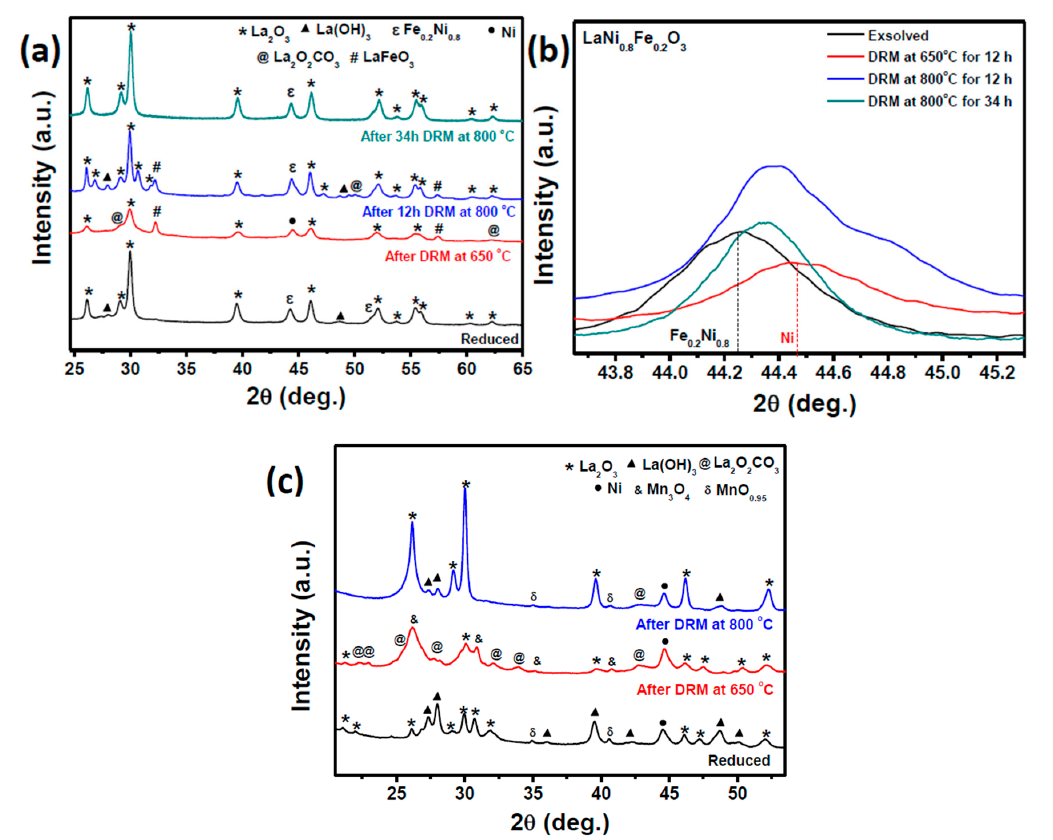
Figure 5. XRD patterns of reduced, after dry reforming reaction at 650 and 800 °C of ( a ) LaNi 0.8 Fe 0.2 O 3 and ( c ) LaNi 0.8 Mn 0.2 O 3 perovskites; formation of ( b ) Ni-Fe alloy at different reaction conditions of LaNi 0.8 Fe 0.2 O 3 perovskite.